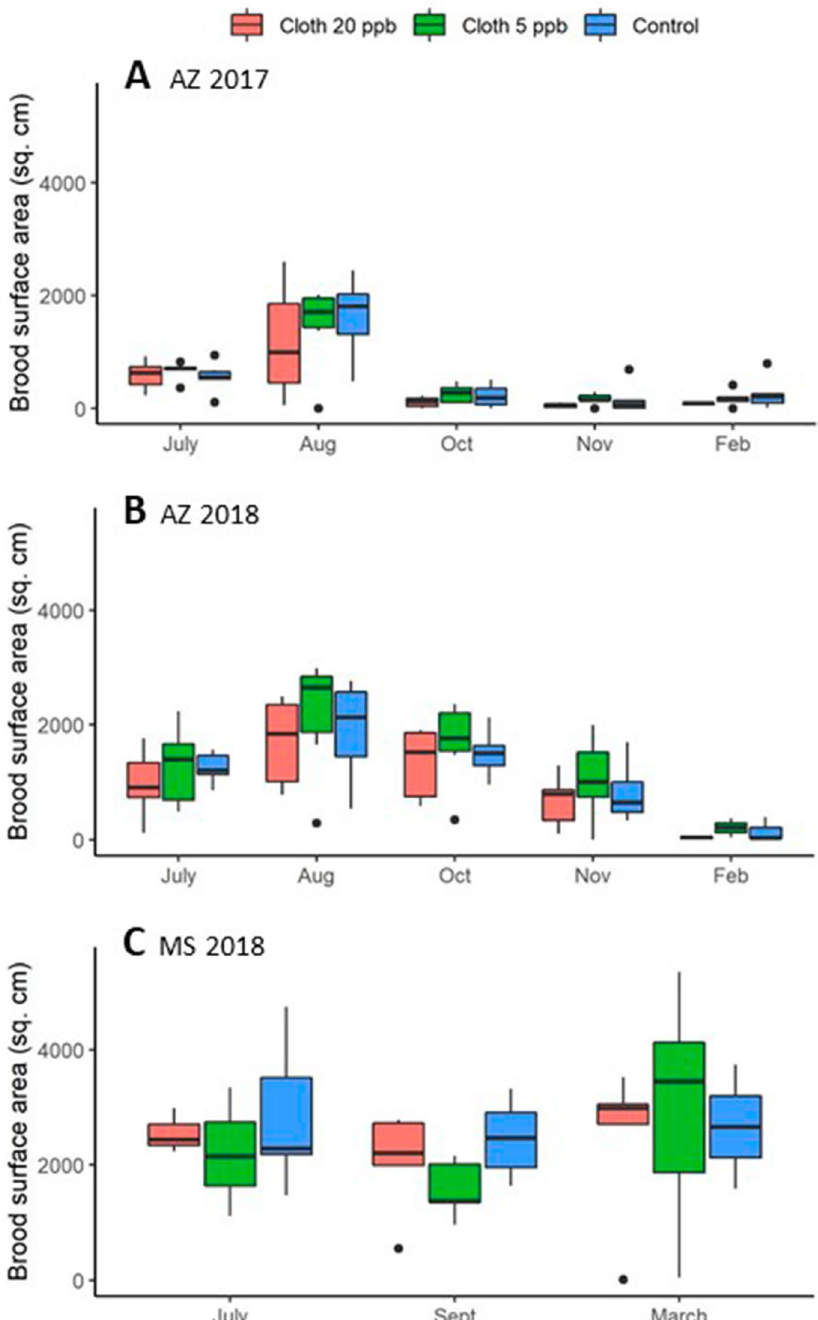
Figure 3. Average brood surface area (cm 2 ) per colony for each of 3 treatment groups: Clothianidin 20-ppb (orange), clothianidin 5-ppb (green), control (blue). ( A ) AZ 2017; ( B ) AZ 2018; ( C ) MS 2018. Boxes are defined as 1.58 * IQR/n 0.5 , where IQR is the inter-quartile range and n is the number of data